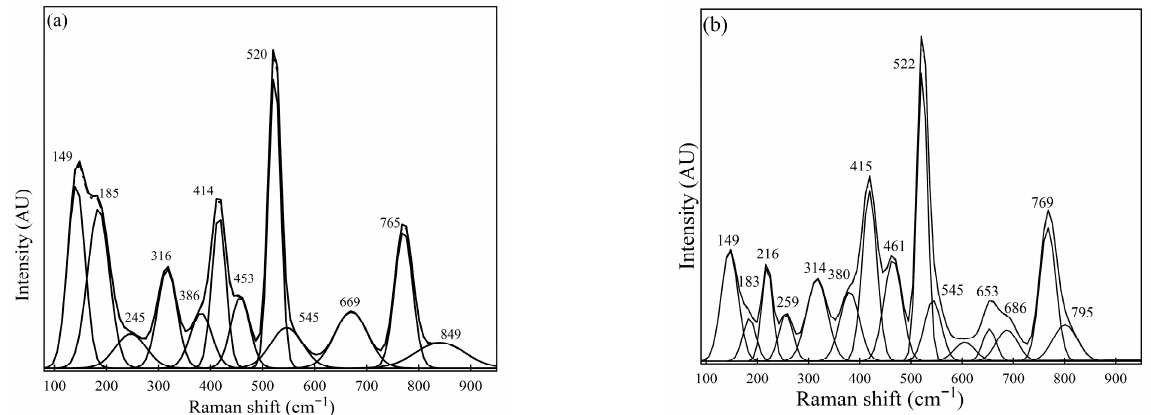
Figure 4. Raman spectra for Sample #3 were measured using ( a ) spot measurements and ( b ) sample rotation (using the rotating stage).